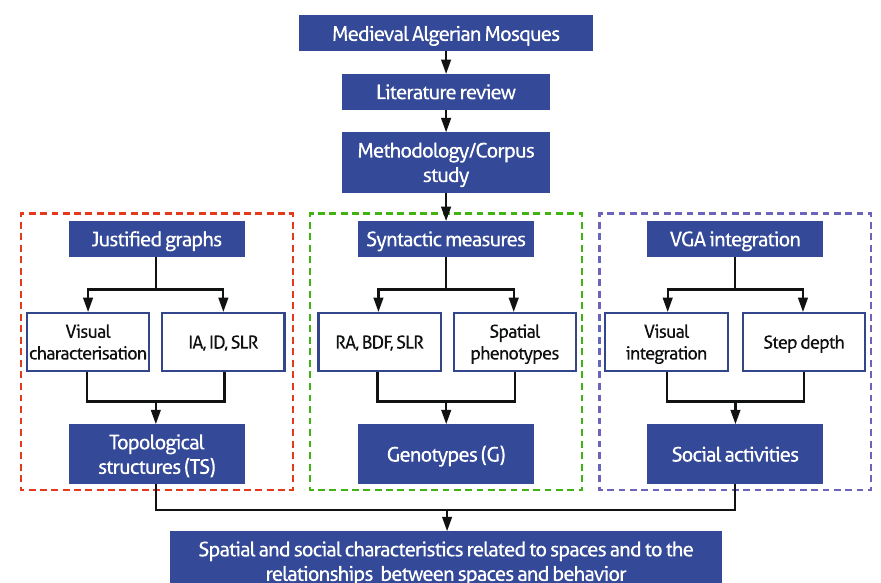
Fig. 1 Analytical framework of the general structure of the research (Source: the